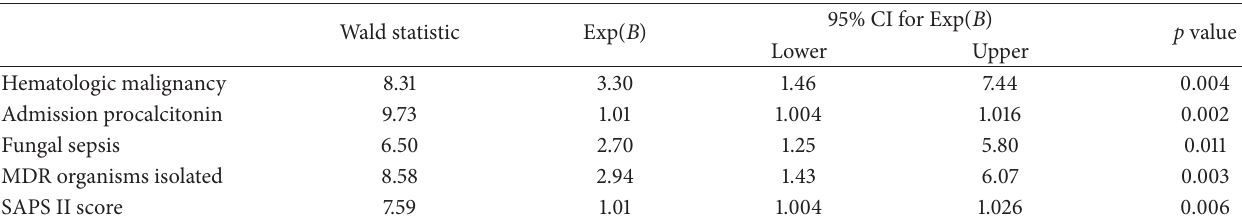
Table 4: Multivariate regression analysis to indicate variables associated with no deescalation of